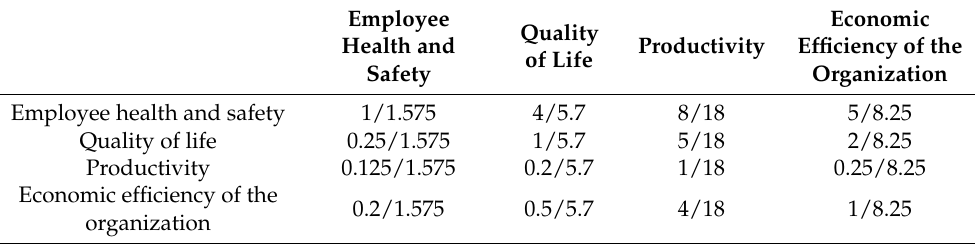
Table 3. Hierarchical synthesis.